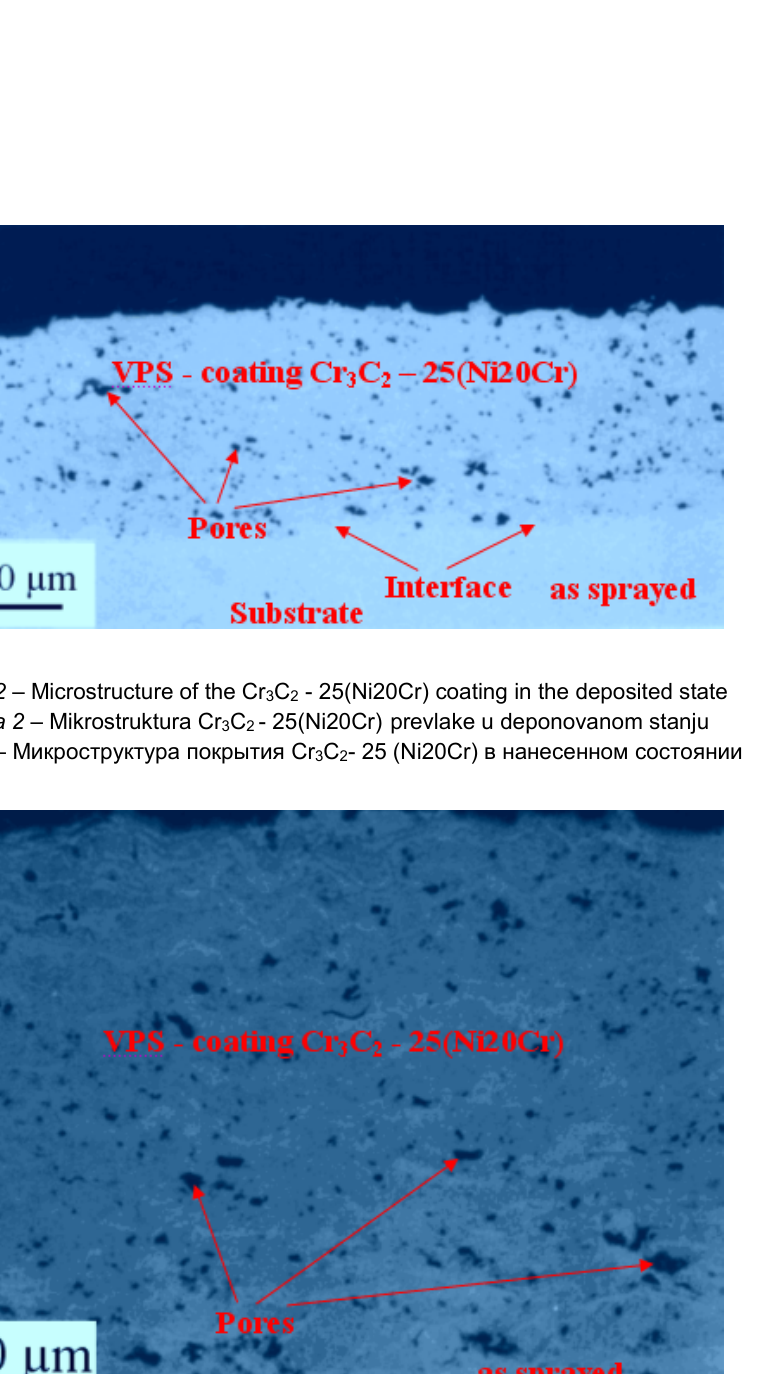
Рис . 3 – Микроструктура покрытия Cr 3 C 2 - 25 (Ni20Cr) в нанесенном